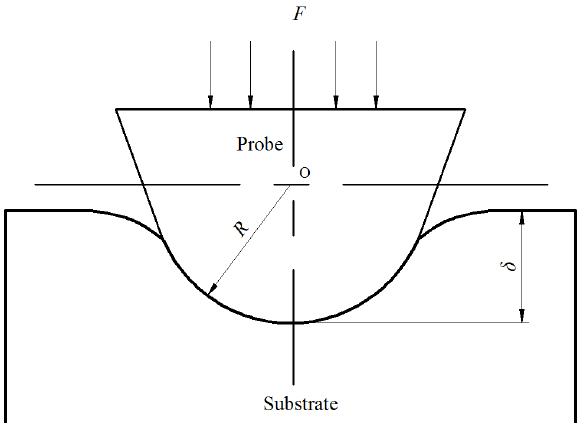
Figure 2. Nanoindentation diagram of the spherical tip .